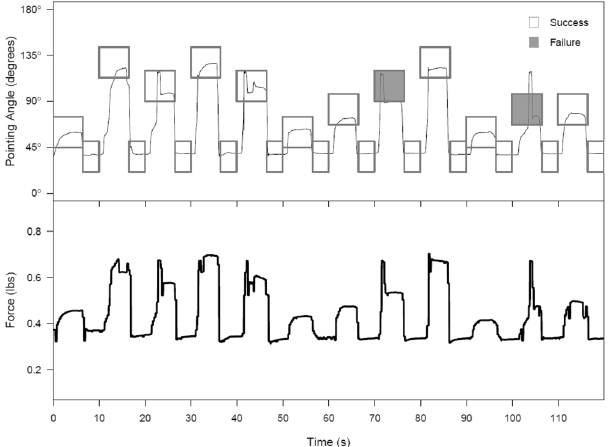
Figure 4. The participant generated graded muscle contractions to pull against resistance and point at various target angles. The top figure shows the cued angle (rectangles) and the angle at which the participant was pointing (solid black line) for the first training block. If the participant was successful for a given cue (within 15° of the cue for 2 s continuously), the rectangle is clear; if he failed the cue, it is shaded gray. The bottom figure shows the force measurement in pounds as measured by the load cell aligned in time for the same block. The force exerted closely tracks the wrist flexion as measured by the pointing angle (correlation coefficient 0.933 ± 0.006).